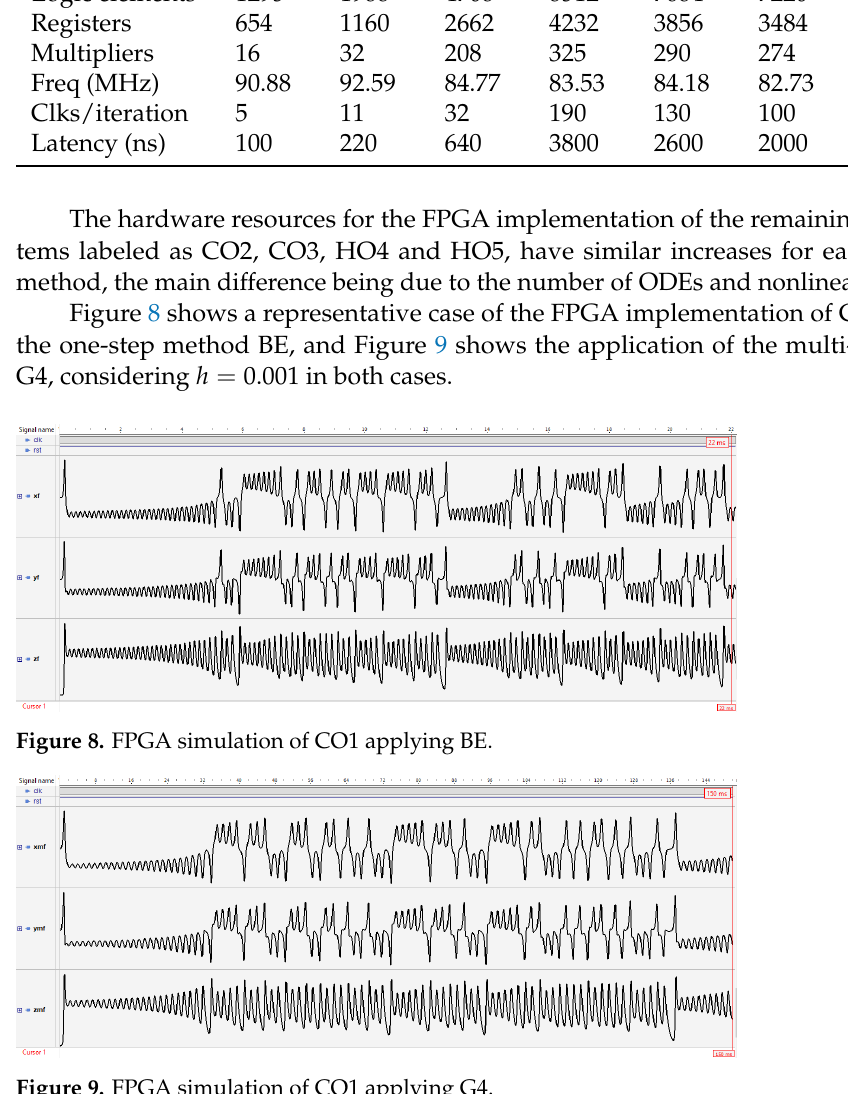
Figure 9. FPGA simulation of CO1 applying